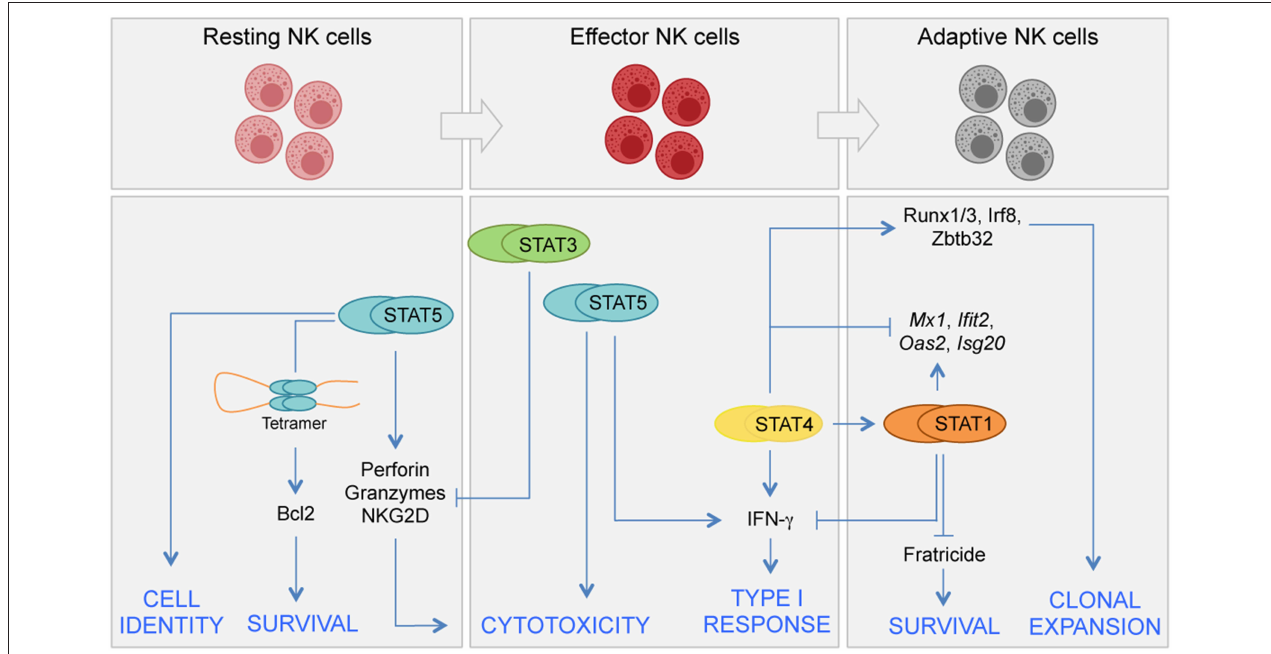
FIGURE 1 | Distinct requirements for STATs in NK cell differentiation. JAK/STAT signals control several aspects of NK cell biology, including development, terminal differentiation, acquisition of effector functions, and generation of adaptive NK cells. NK cell development begins in the bone marrow from committed precursors and it is driven by signals inducing STAT5 activation. In homeostatic conditions STAT5 sustains NK cell survival by direct regulation of Bcl2 expression. STAT5 is also required for terminal differentiation and acquisition of NK cell identity. STAT4 and STAT1 have both specific and shared roles during viral infection. STAT4 controls a network of TFs required for clonal expansion of NK cells during proliferation. STAT4 and STAT1 compete at genomic level for the expression of IFN- γ and other genes. STAT3 has a role in restraining NK cell effector functions by inhibiting perforin, granzyme B, and NKG2D